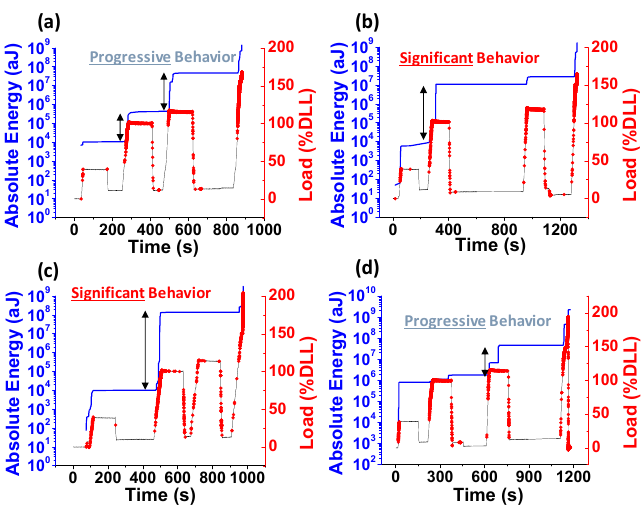
Figure 5. Additional examples of AE activity during four tests with some progressive and some significant behavior observed. ( a ) Test 5, ( b ) Test 3, ( c ) Test 15, and ( d ) Test 13. Felicity ratio values for all spars at each loading step are given in Table 2. Most test